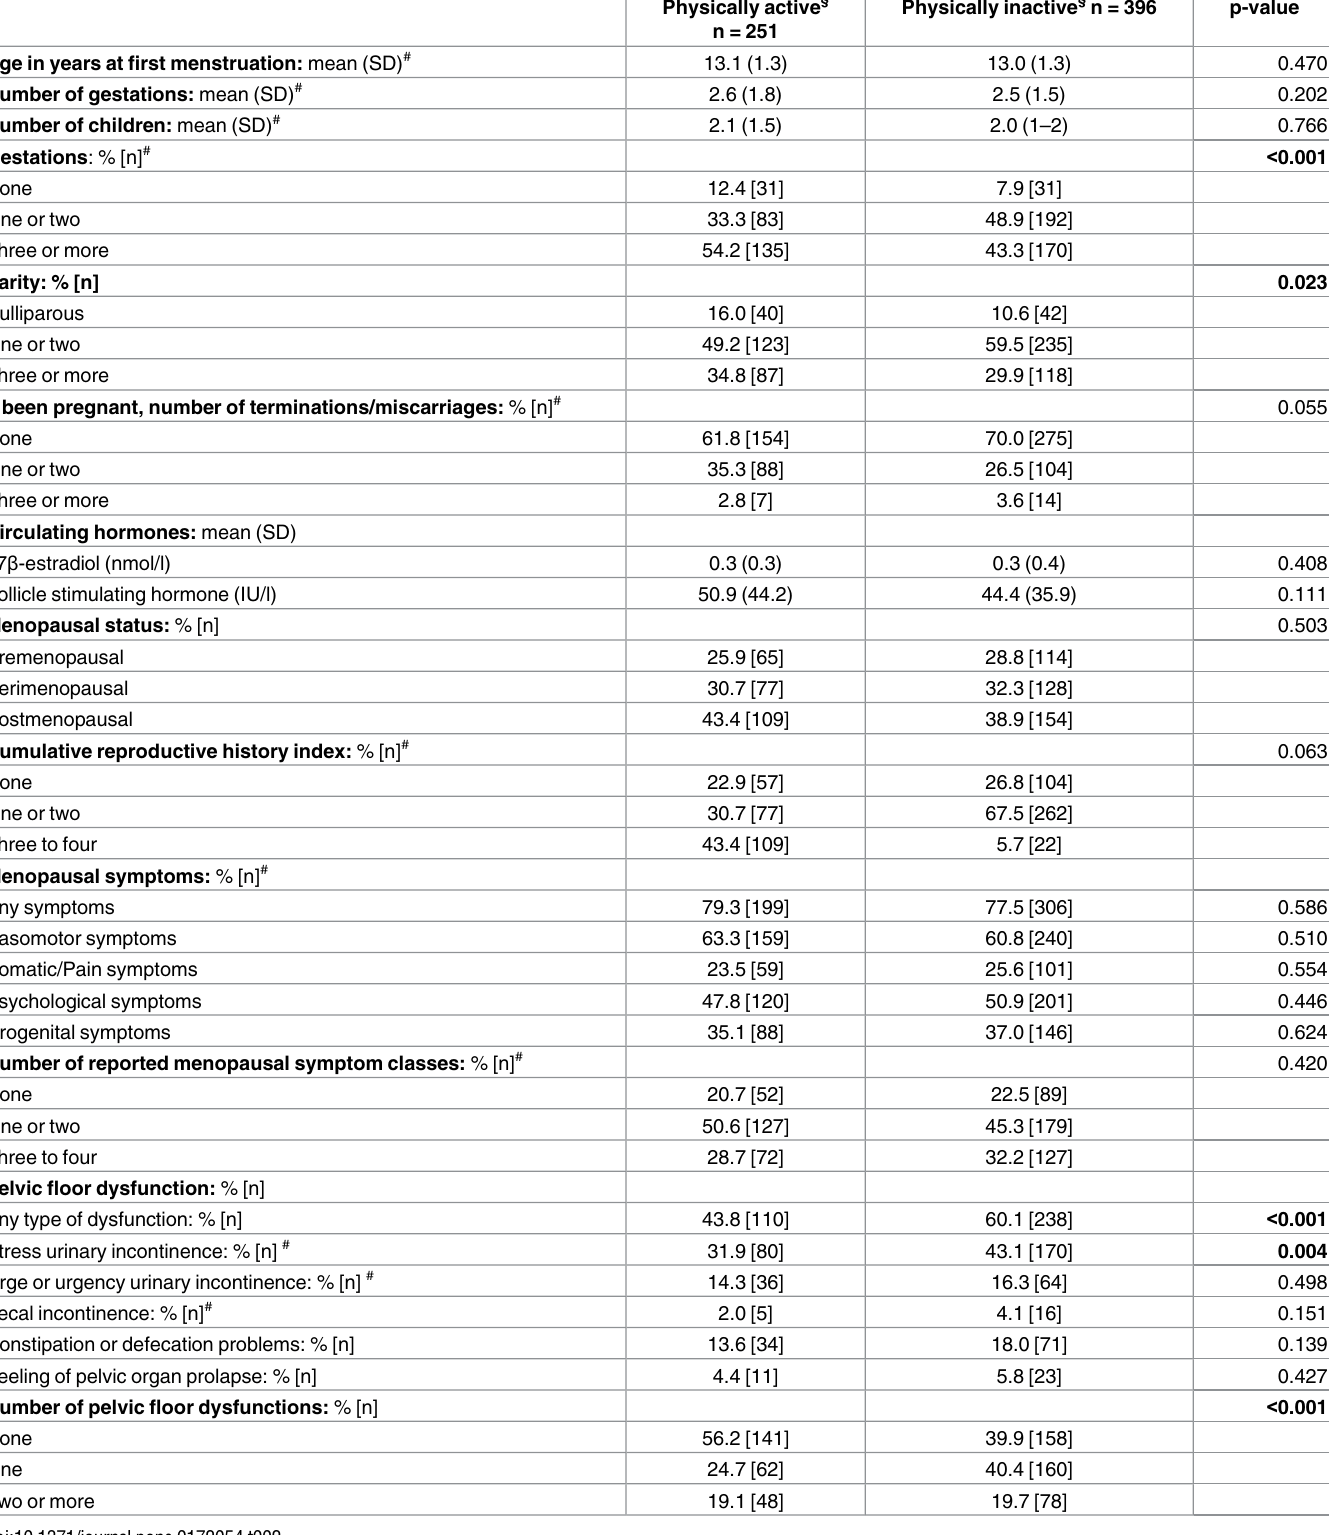
Table 2. Characteristics associatedwith female reproductive